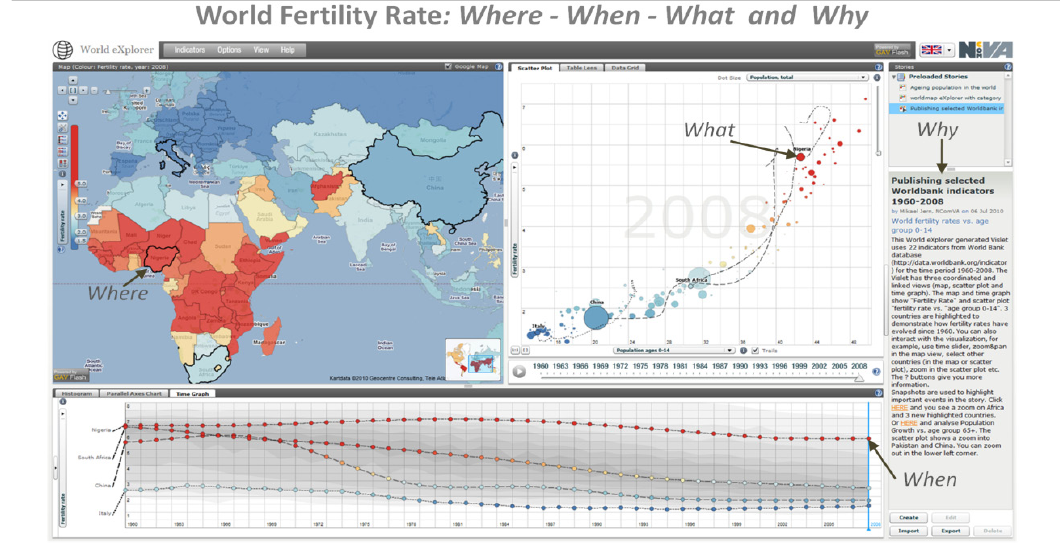
Figure 1. Open Statistic eXplorer with 3 time-linked views showing the world “fertility rates” during 1960–2008; map, scatter plot (fertility rate vs. age 0–14) and time chart; comparing 4 countries Nigeria, South Africa, China and Italy. The story is published on the right side. Students learn that central Africa maintains a high fertility rate (Nigeria), while South Africa started in 1960 at the same level but then shows a reduced trend. The students can interact and change indicators to discover reasons behind this trend and